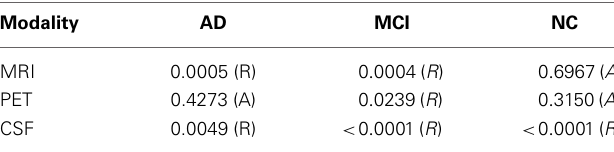
Table 2 | A summary of Henze-Zirkler’s multivariate normality test on our dataset.